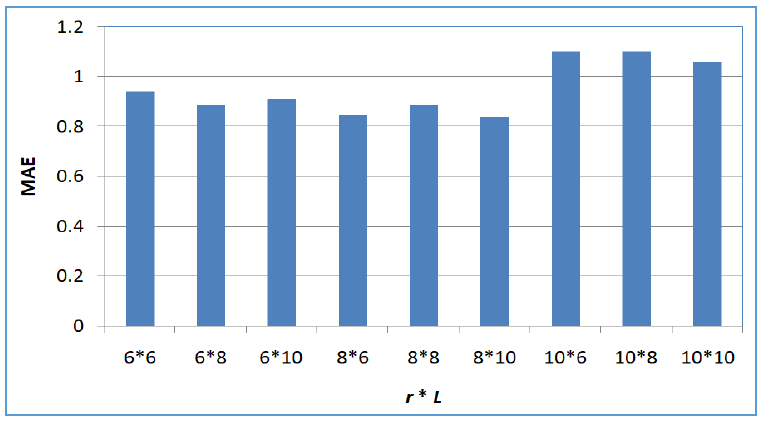
Figure 5. Accuracy of SerRec converse-LSH .